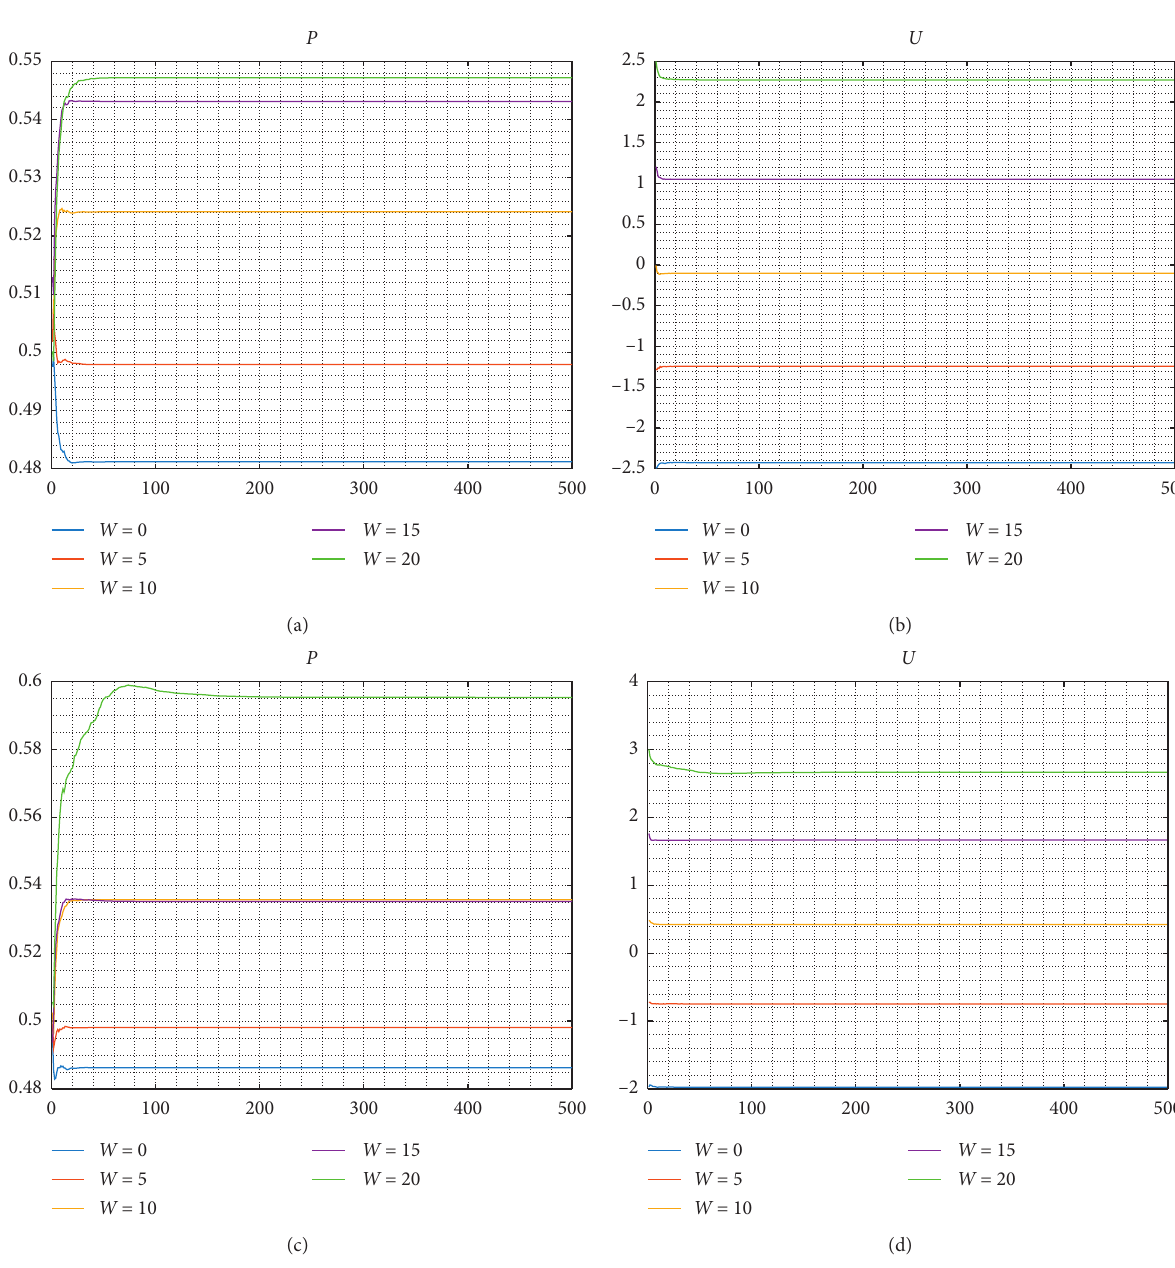
Figure 7: The simulated results of situation 5. (a) P (Case 1). (b) U (Case 1). (c) P (Case 2). (d) U (Case